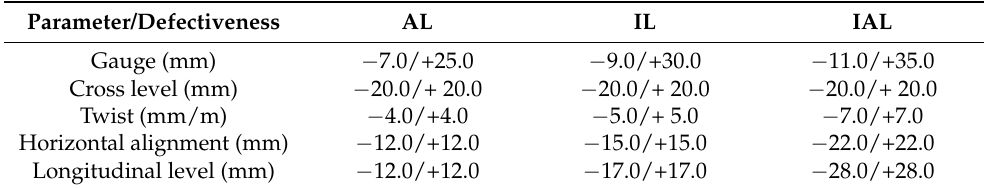
Table 2. Alert Limits (AL), Intervention Limits (IL), and Immediate Action Limits (IAL) for line speeds of up to 80 kph according to EN 13848-5 [34].